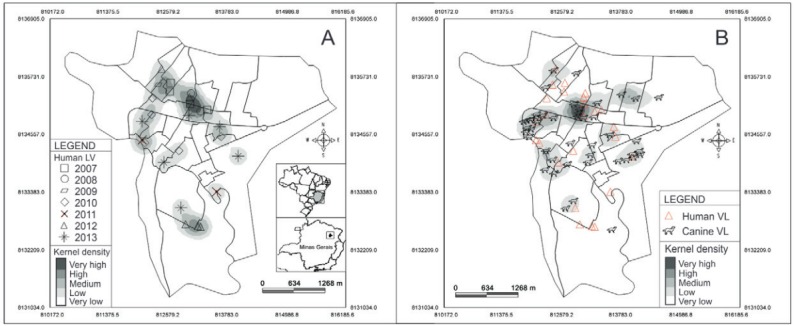
: kernel map of visceral leishmaniasis in the urban area of Araçuaí, Minas Gerais, Brazil. (A) Human visceral leishmaniasis (2007-2013); (B) canine visceral leishmaniasis (2013). Limits represent census lines according to the 2010 census.